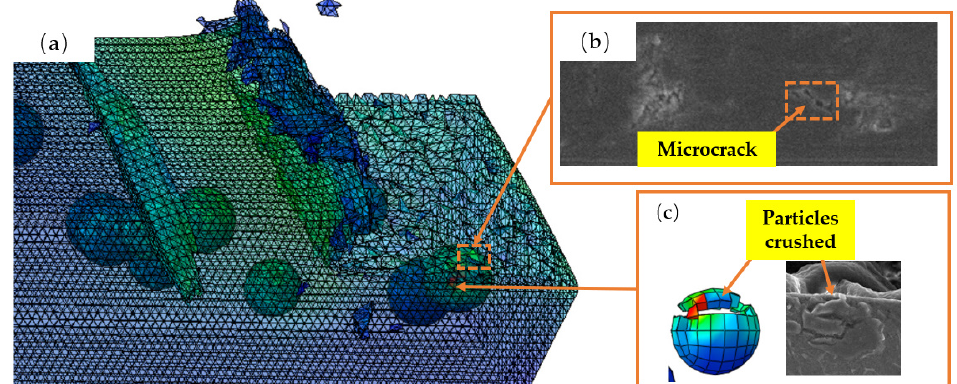
Figure 14. Machining surface micro-crack: ( a ) simulated particles are removed to form micro-crack; ( b ) the surface micro-crack SEM image after turning to process; ( c ) diagram of TiC particles crushed.